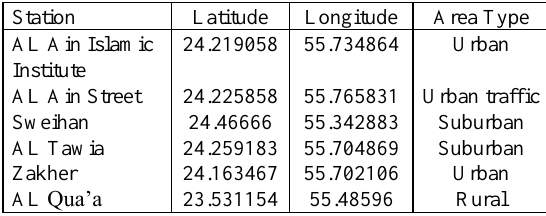
Table 1 . Air monitoring stations in the study